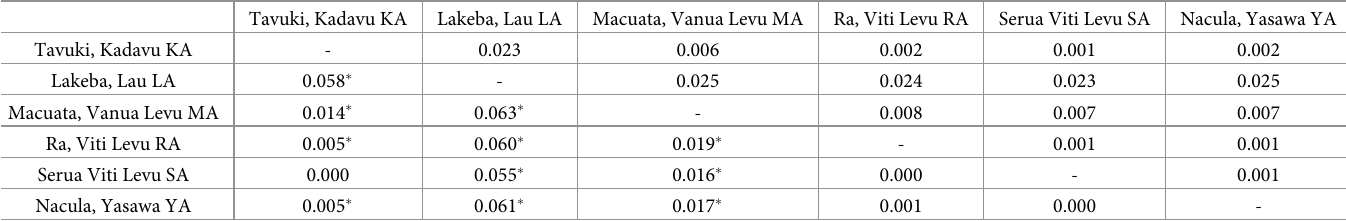
Table 2. Pairwise population differentiation estimates computed for Holothuria scabra sampled using 6,896 SNPs. Pairwise F st values (Weir and Cockerham’s 1984 unbiased method) are reported below the diagonal, and were generated in Arlequin v3.5.1.3 following 1,000 permutations. Nei’s (1978) standard genetic distances ( D S ) are reported above the diagonal and were computed in Genetix v4.05.2 with 10,000